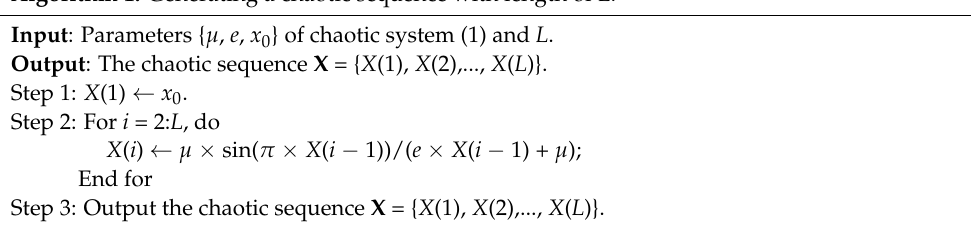
Algorithm 1. Generating a chaotic sequence with length of L